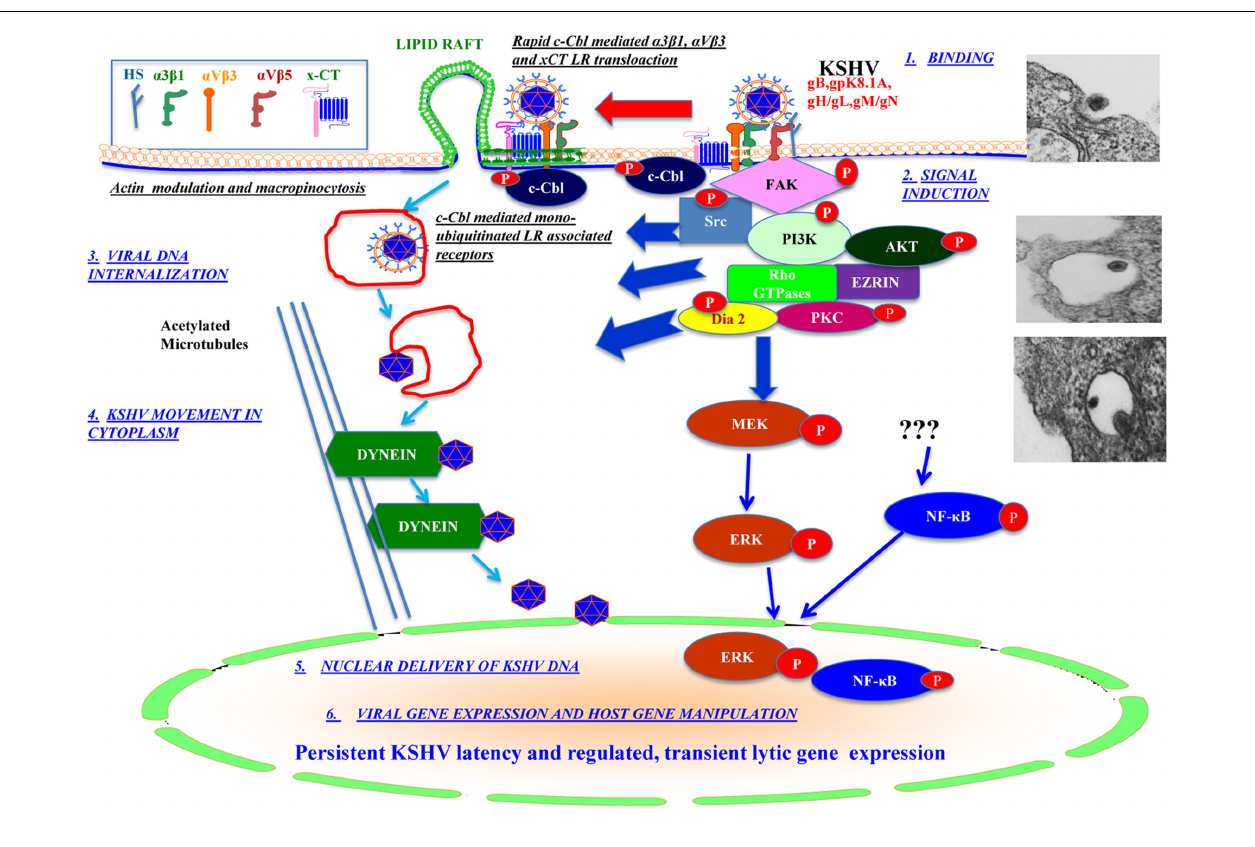
FIGURE 1 | Schematic model depicting the different overlapping phases of KSHV entry and infection in endothelial (HMVEC-d) target cell. KSHV infection is initiated by binding to the cell surface proteoglycan heparan sulfate [HS; Stage 1: binding; inset electron microscopic, (EM) picture], followed by subsequent temporal associations with integrins ( α 3 β 1, α V β 3, α V β 5) and xCT molecules in the non-lipid raft (NLR) parts of the